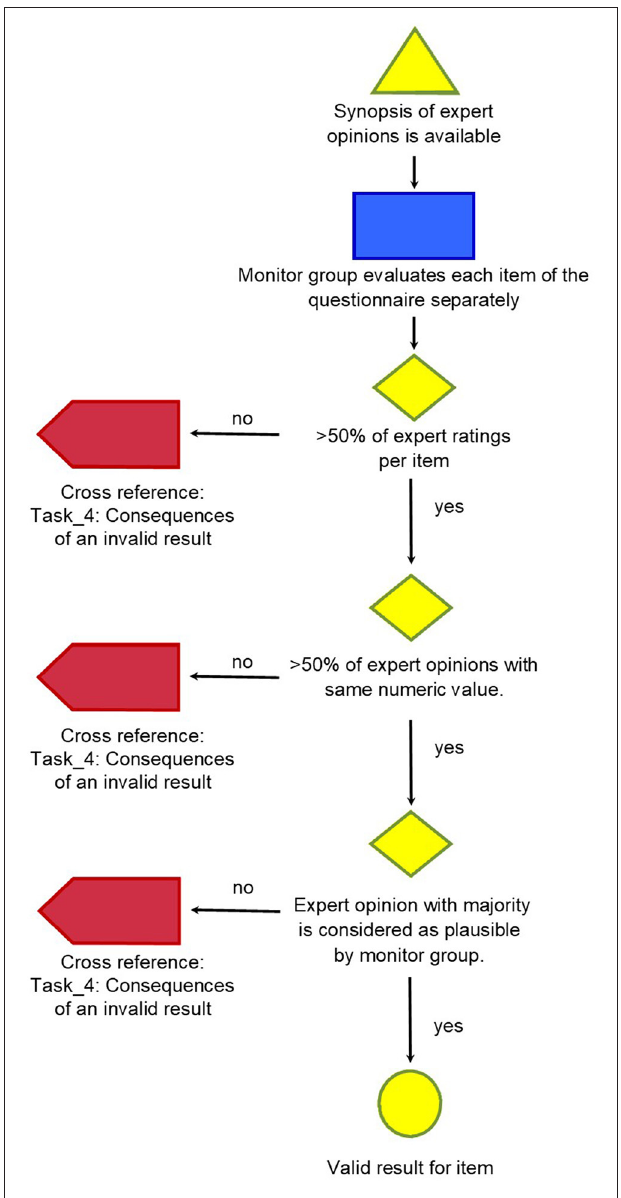
FIGURE 3 | Task_3: Evaluation of single items of the questionnaire in synoptic presentation.